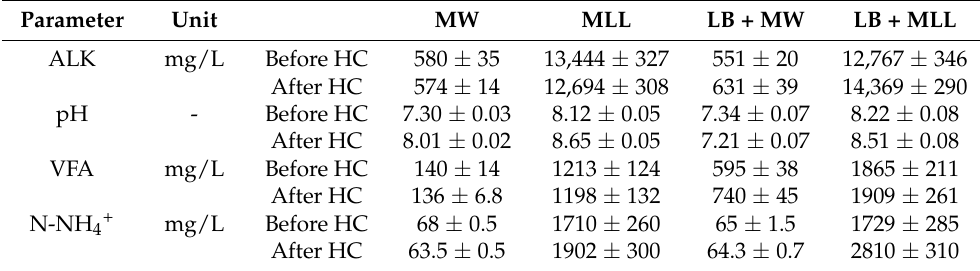
Table 3. Mixture composition in terms of AD application before and after cavitation (average values and standard deviations are